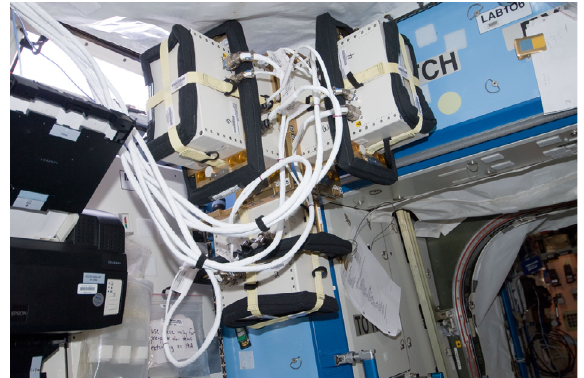
Fig. 5. The ALTEA experiment in Shield-Survey 3D configuration in the USLab module on board the